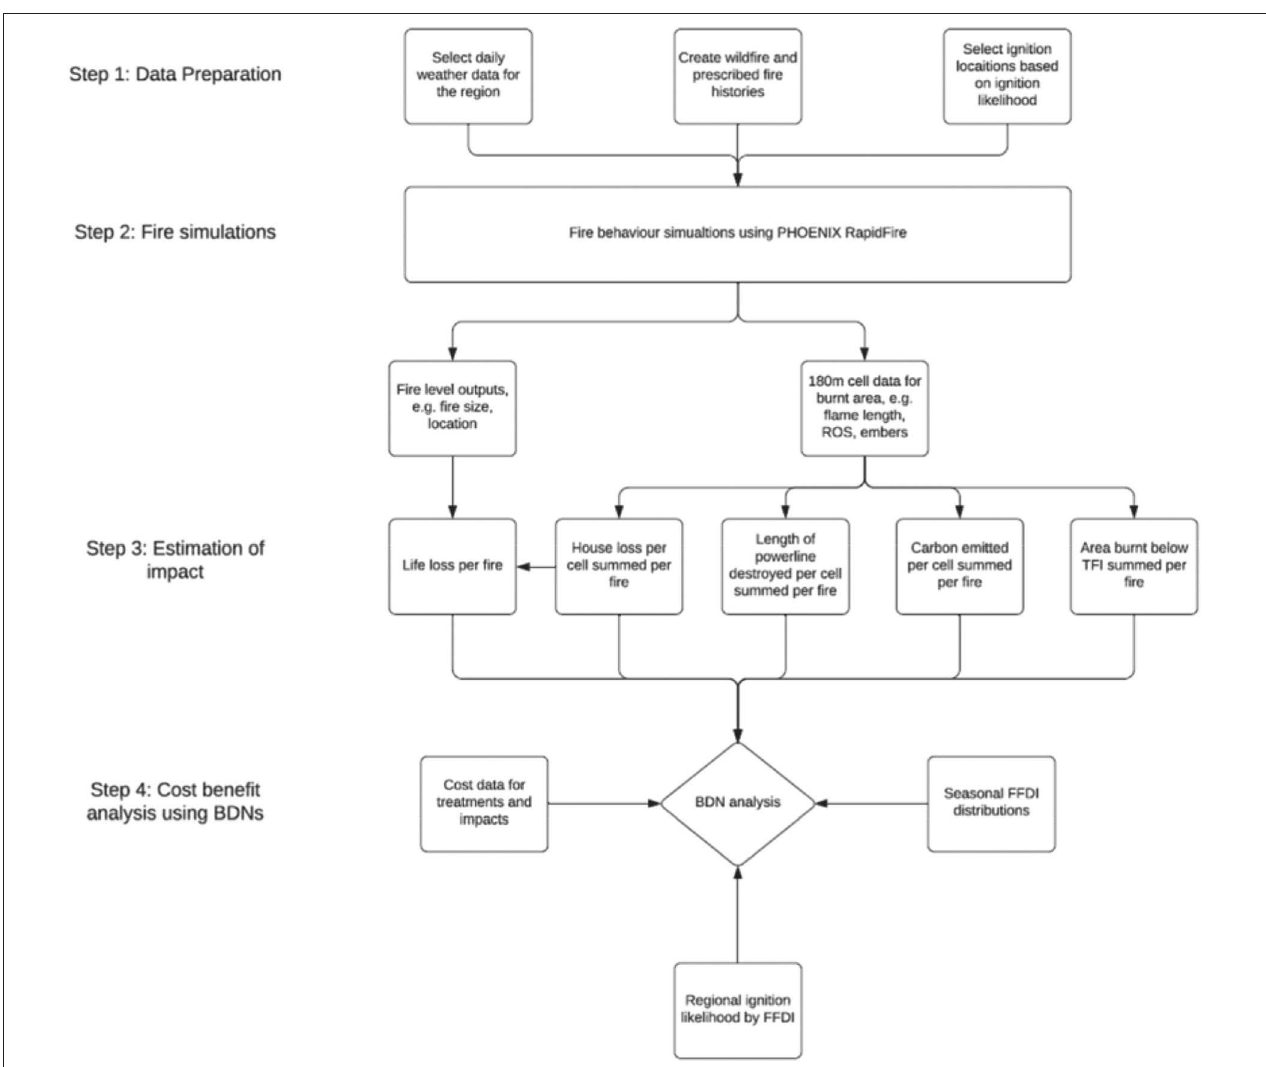
FIGURE 2 | Workflow for the study. ROS, rate of spread; BDN, Bayesian decision network; TFI, tolerable fire interval; FFDI, forest fire danger